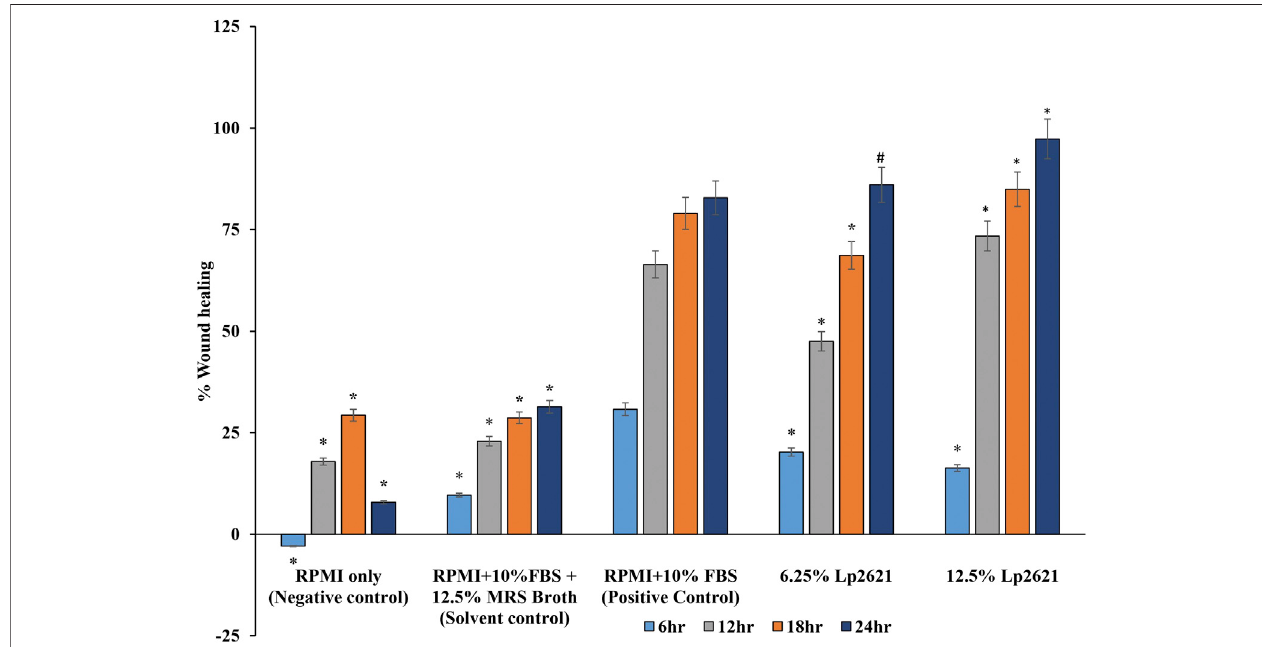
FIGURE 4 | Wound healing percent (%) in scratch assay after 6, 12, 18, and 24 h post-treatment with Lp2621. Data are representative of two independent experiments performed in triplicates and expressed as mean ± SE.*, and # mean p < 0.001 and p (cid:1) 0.003.